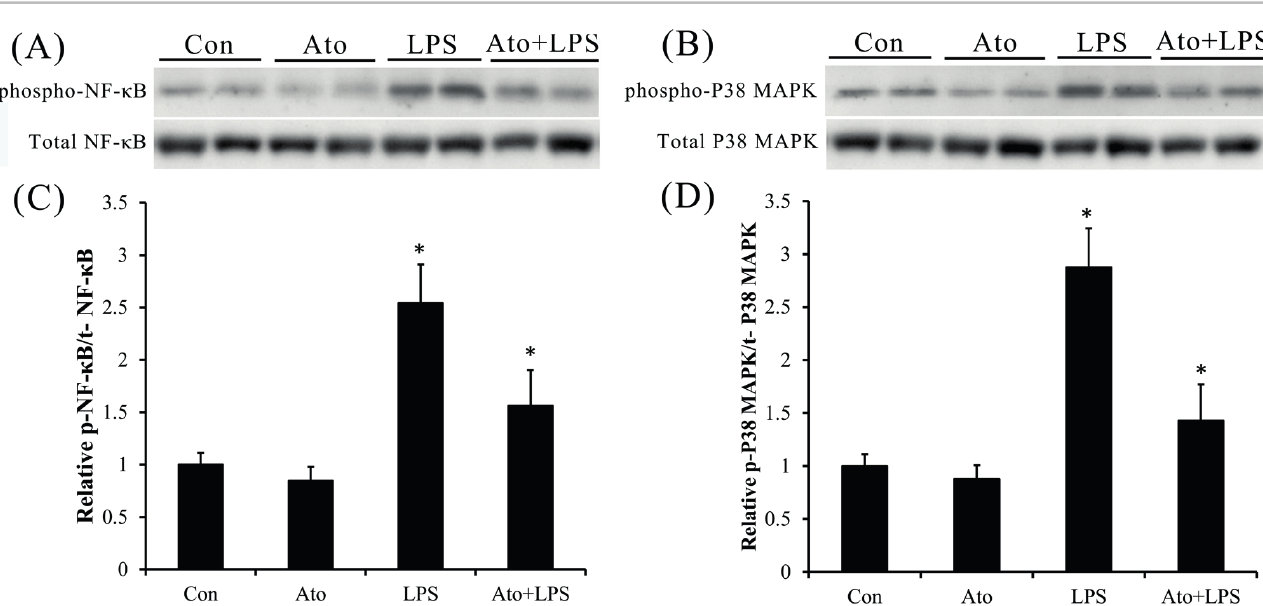
FIGURE 5 - The effects of atorvastatin on the phosphorylation of NF- κ B and p38 MAPK, induced by LPS in HCAECs. (A) The pho sphorylation-NF- κ B was assessed by Western blotting after treatment with LPS and atorvastatin (B) The phosphorylation of p38 MAPK was assessed by Western blotting after treatment with LPS and atorvastatin. (C) The phosphorylation of NF- κ B in HCAECs was quantified using densitometry and represented by the ratio of total NF- κ B. Statistical analysis was performed on Ato, LPS and Ato+ LPS versus Con group, respectively. (D) The phosphorylation of p38 MAPK in HCAECs was quantified using densitometry, and represented by the ratio of total p38 MAPK. Statistical analysis was performed on Ato, LPS and Ato+ LPS versus Con group, respectively. Data are expressed as mean values SE of three independent experiments. *P<0.05 indicates significant